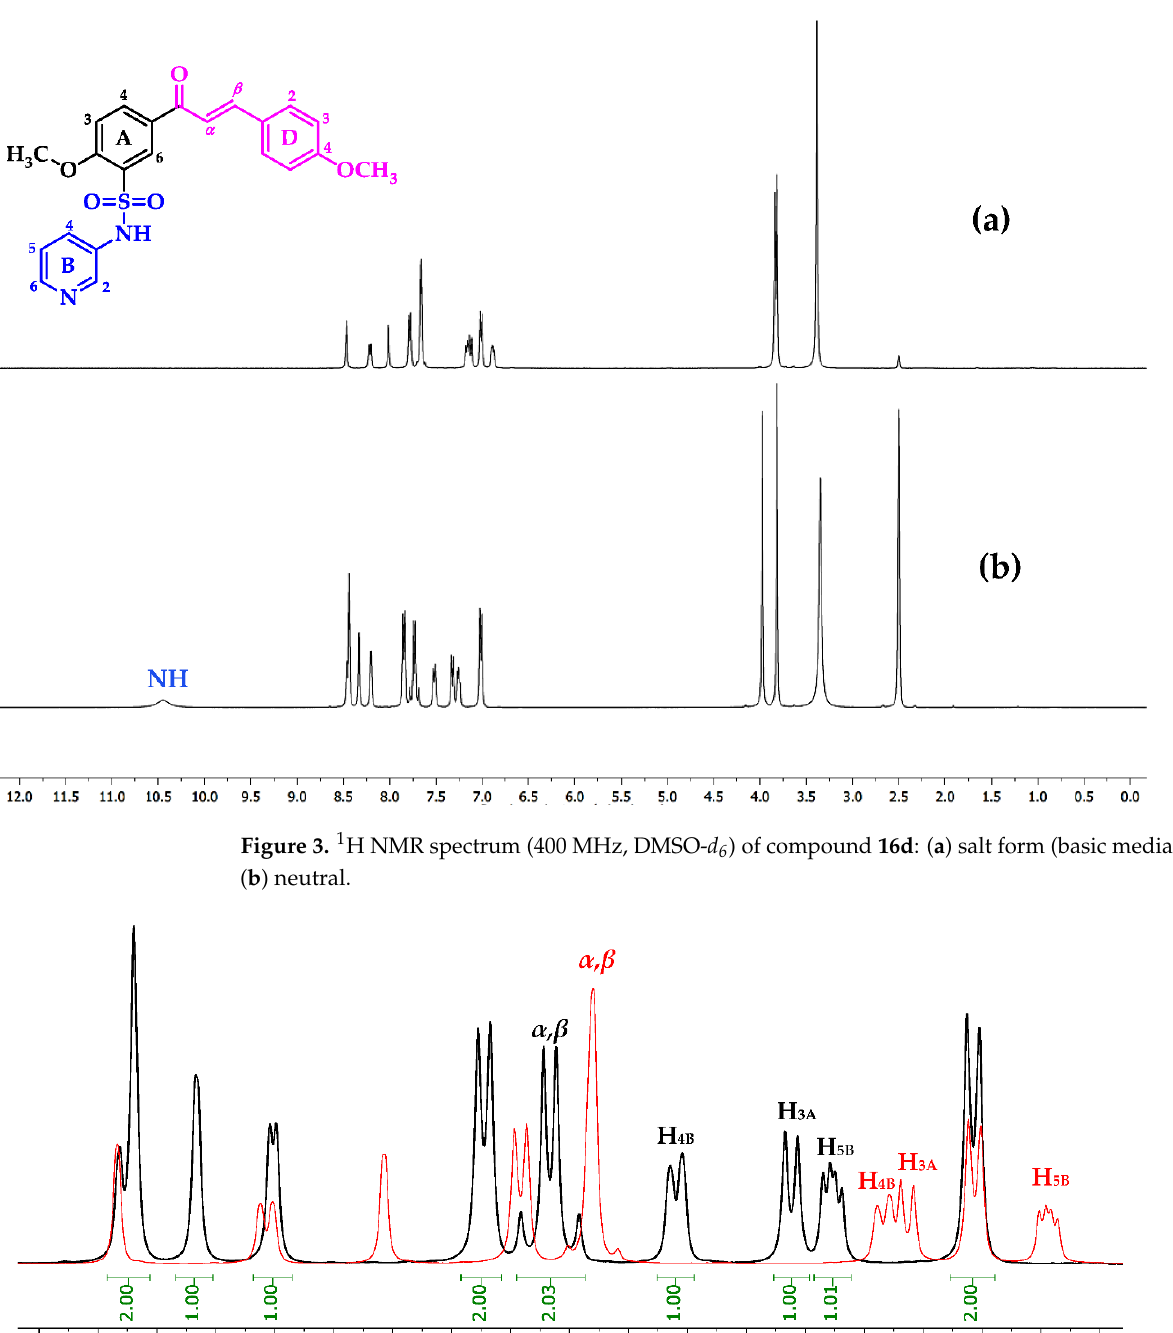
Figure 4. Chemical shift between 1 H NMR signals of compound 16d in salt form (red) and neutral (black).